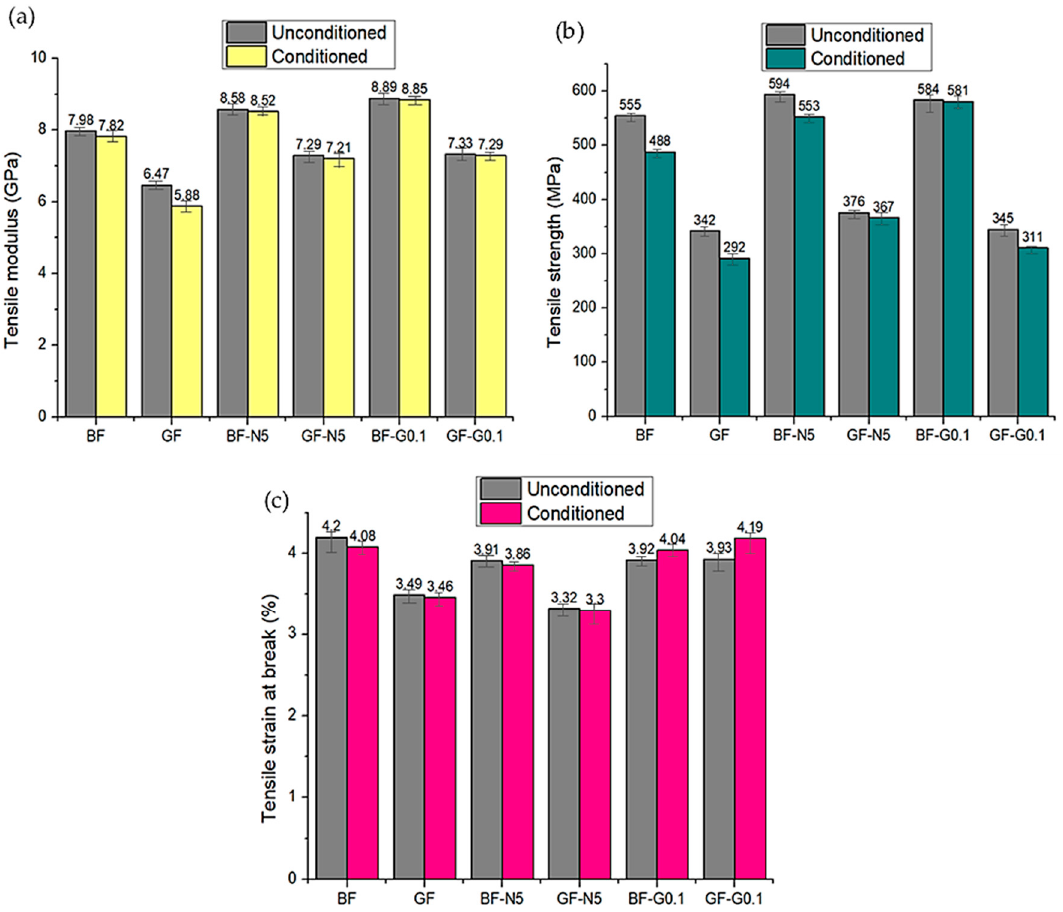
Figure 8. Effect of accelerated weather conditions on the ( a ) tensile modulus, ( b ) tensile strength, and ( c ) tensile strain at break of BFRP and GFRP composites.